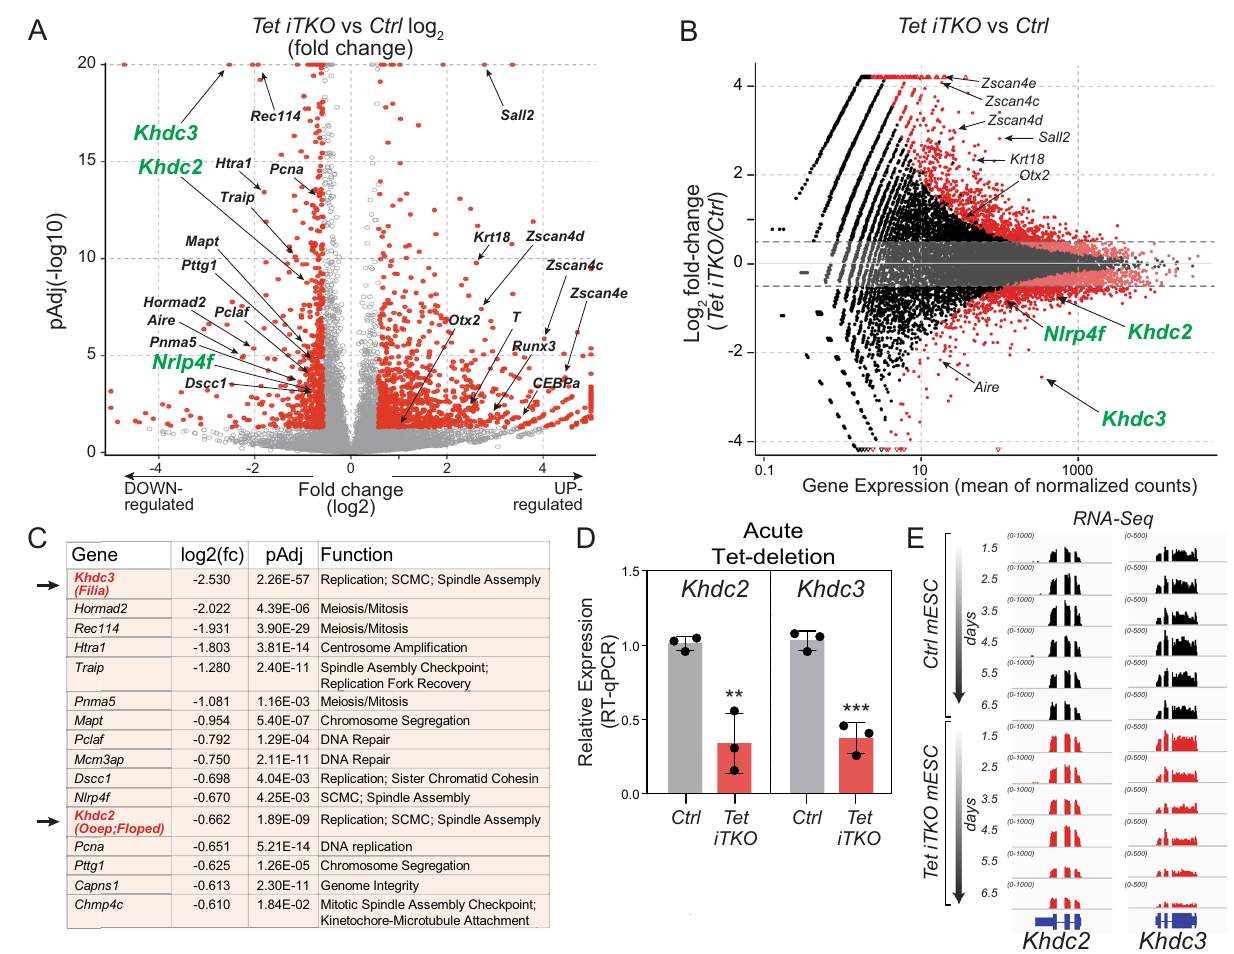
Fig. 3 | Acute Tet1/2/3 depletion induces altered expression of many genes, including downregulation ofmRNAs encoding the SCMCsubunitsKHDC2 and KHDC3.A Volcanoplotof differentiallyexpressedgenes(DEGs)inacutely-deleted Tet iTKO relative to Ctrl mESC. The data are from Smart-Seq2 libraries prepared from sorted H2B-EGFP+/CD90.2-/SSEA1+/CD326+ Ctrl or Tet iTKO mESC at day 6.5 post-4-OHT exposure. Each point represents an individual transcript. Red dots represent transcripts exhibiting log2foldchange(log2FC) of +/ − 1 and a pAdjvalue <0.05 (calculated by adjusting the p-value with the false discovery rate [FDR]). ArrowspinpointkeyDEGs. Khdc2 ( Ooep ), Khdc3 ( Filia )and Nlrp4f mRNAs,whichare downregulated in Tet iTKO compared to Ctrl mESC and encode core (KHDC2) and more peripheral (KHDC3, NLRP4F) components of the subcortical maternal